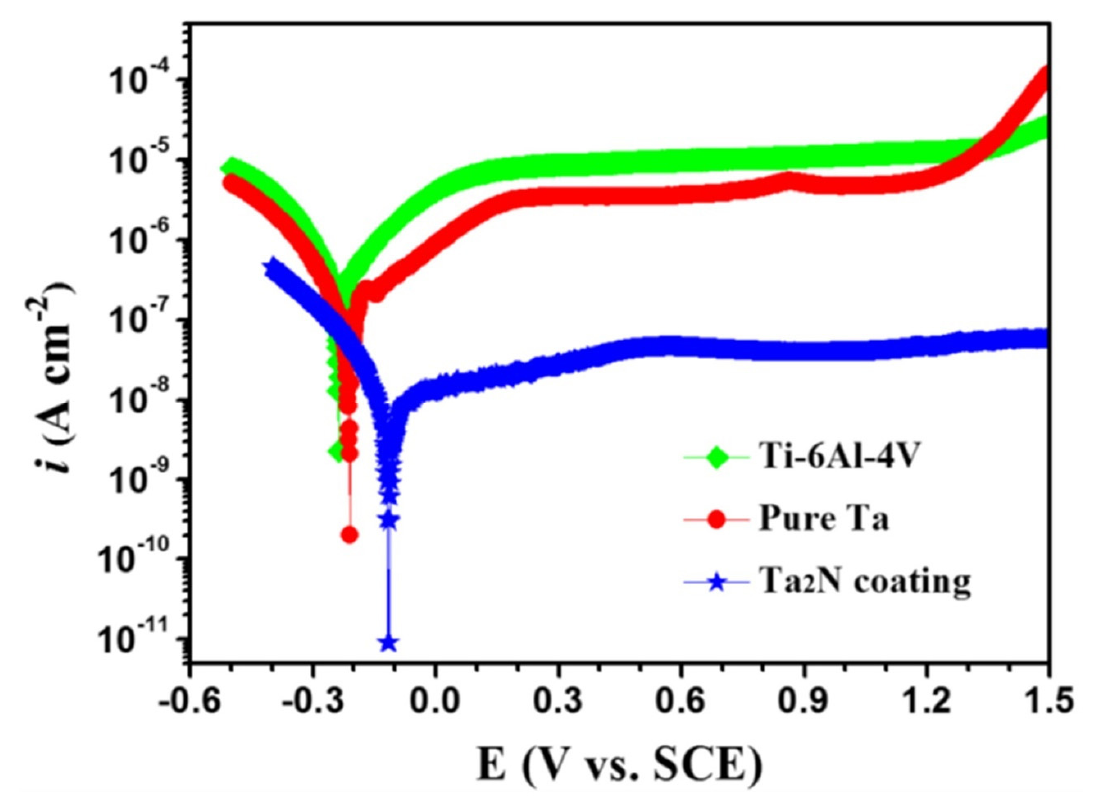
Figure 4. Potentiodynamic polarisation curves of bare Ti-6Al-4V, pure Ta and Ta 2 N coating [83]. Tantalum-based nanocoatings of Ta 2 O 5 , Ta 3 N 5 and TaON (tantalum oxynitride) de-